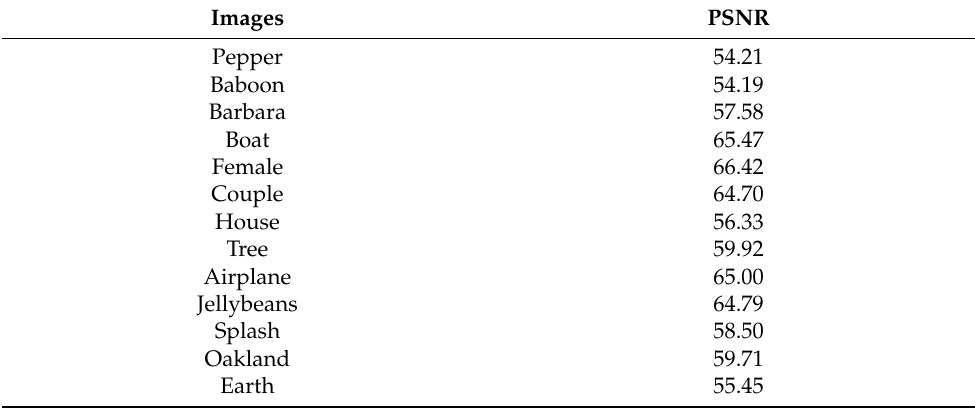
Table 4. PSNR for the standard dataset